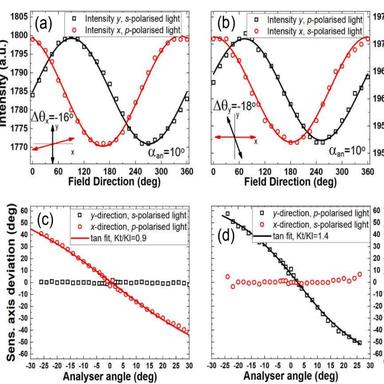
(a) Integral image intensity as a function of field angle with s-polarised light along the y-axis (a)] and (b) with the polariser rotated by 90◦, resulting in spolarised light along the x-axis. The plots in (c) and (d) show the corresponding deviations of the sensitivity direction from the incident plane. The measurements were done on a 10 nm thick iron film with some native oxide on top. To suppress parasitic Faraday rotations in the objective lens, the measurements were preformed in the pure i